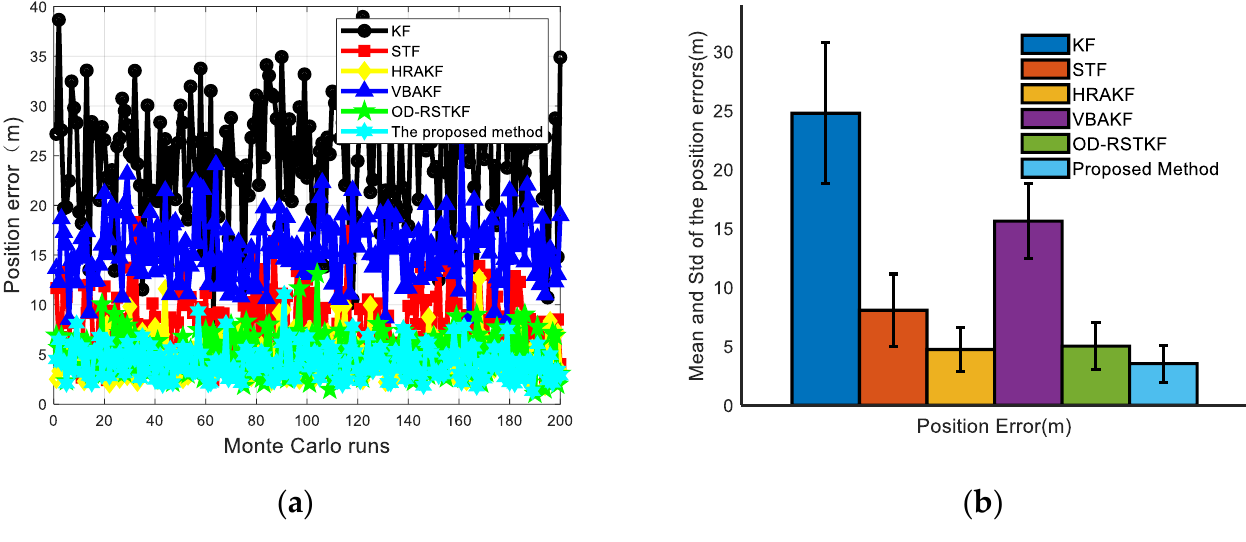
Figure 8. Velocity error results of various filters ( a ) Velocity angle error of various filters under 50 Monte Carlo simulations; ( b ) Mean and STD of velocity errors of various filters under 50 Monte Carlo simulations.